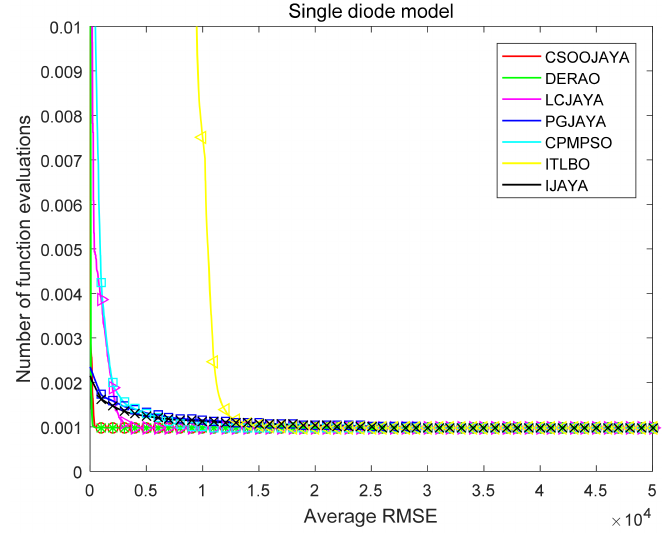
Figure 8. Convergence curves of the seven algorithms on